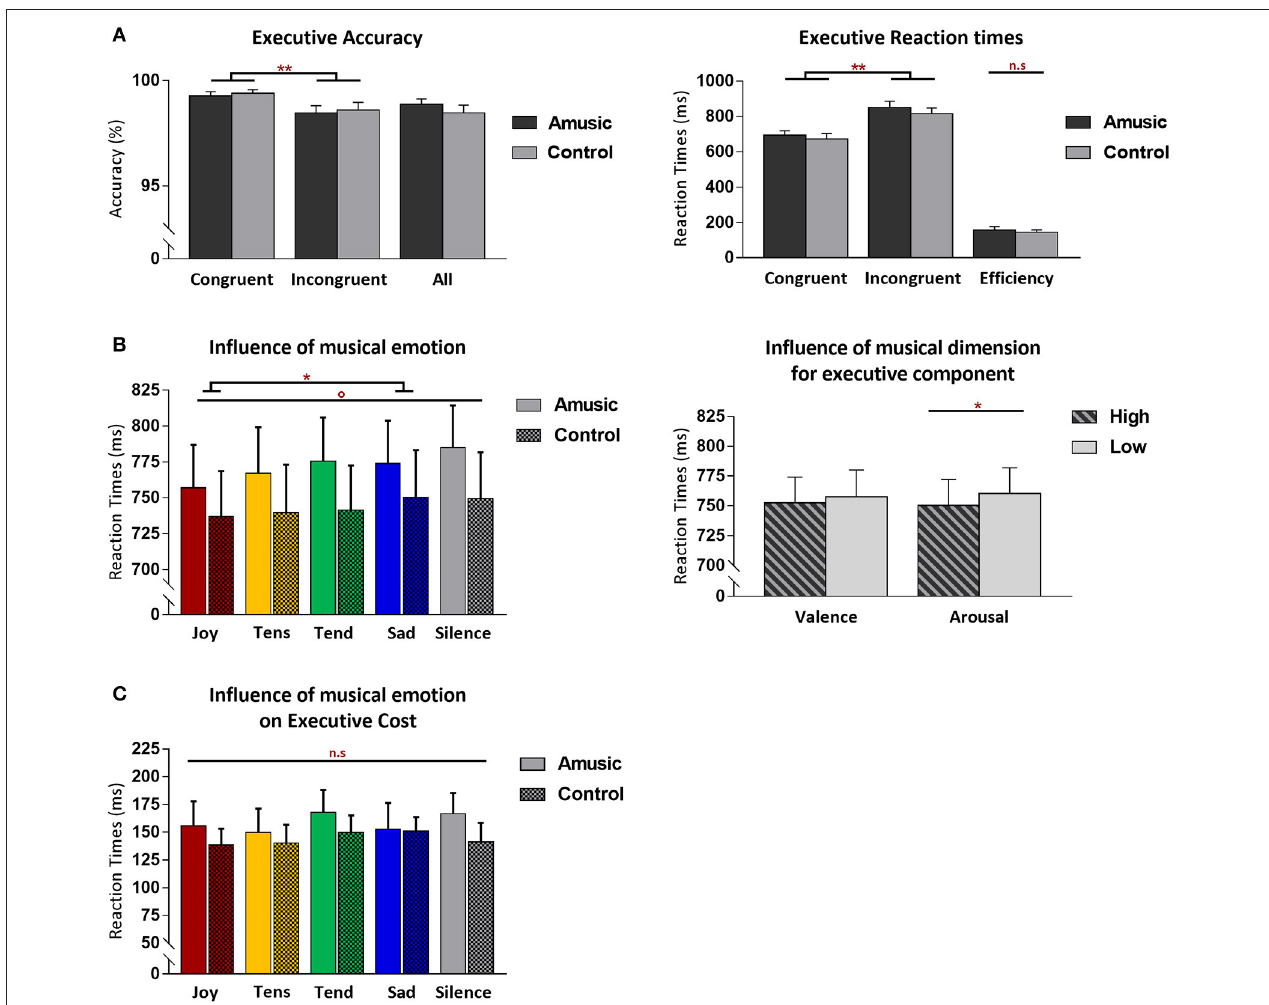
FIGURE 2 | Behavioral results from the Attention Network Task (ANT) for the executive control component of attention, shown for amusic and control participants. (A) Mean accuracy (%) (left) and RT (in milliseconds, ms) (right) for congruent and incongruent target conditions. Mean accuracy (%) from both target conditions merged together, as well as interference cost (ms) [(mean RT Inc -mean RT Con )] are also presented. (B) Mean RT (ms) regardless of congruence and group conditions, as a function of the discrete emotion category of music, plus a silence condition (left) or as a function of the valence and arousal dimensions of music (right) during the task. (C) Executive cost (ms) as a function of the emotion category of music (plus silence), presented without group distinction. Graphs illustrate standard errors of the mean (SEM) and p -values (* or ◦ ) with the following meaning: * p < 0.01; ** p < 0.001; ◦ p < 0.05 without Bonferroni corrections. The n.s. abbreviation indicates non-significant